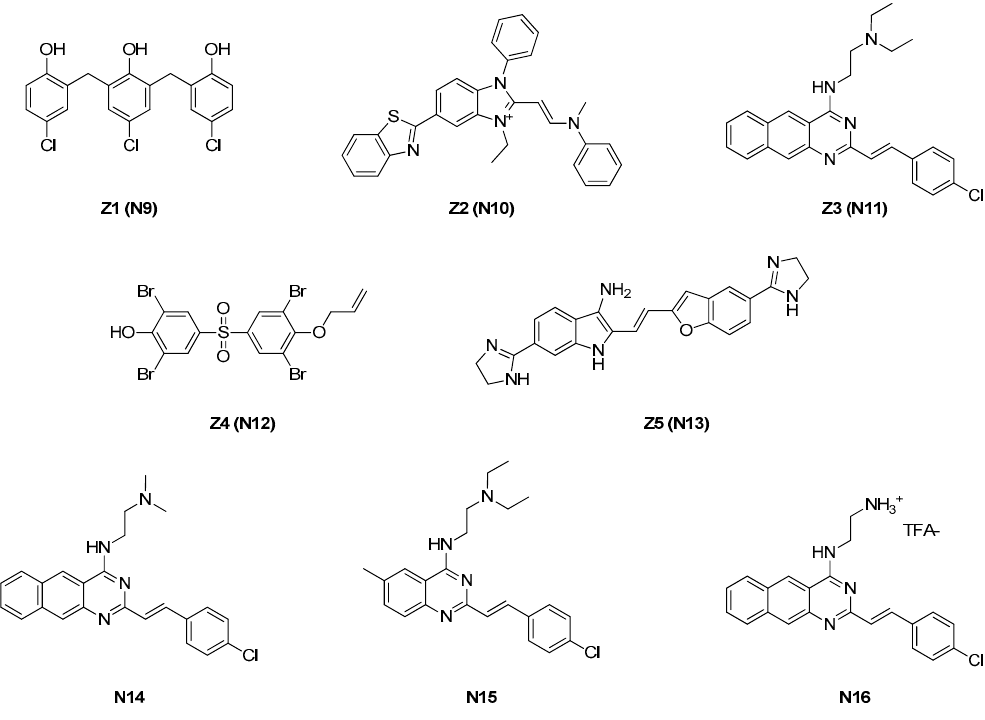
Figure 4. Zantrin FtsZ inhibitors.